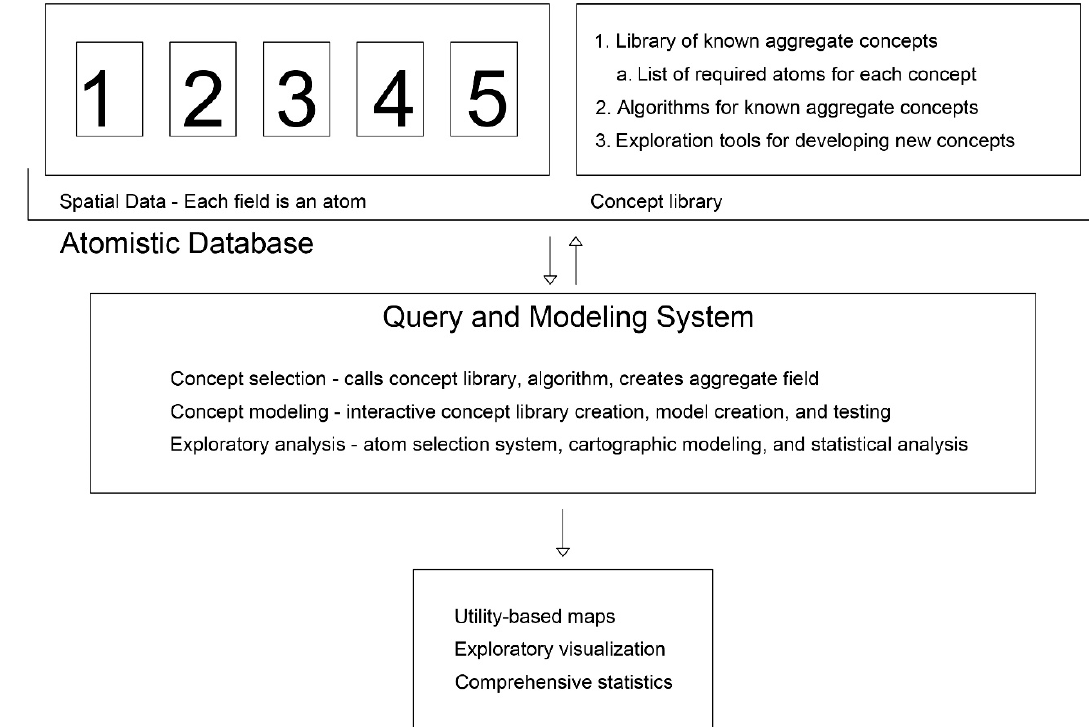
Figure 1. Gray’s exploratory approach [27].